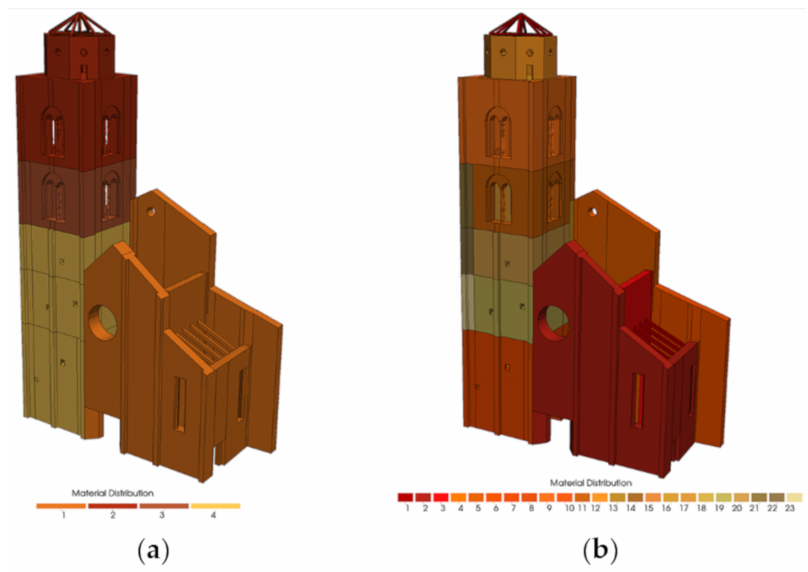
Figure 11. Colormap of the NM with ( a ) four di ff erent material values distributed and with ( b ) twenty-tree material values